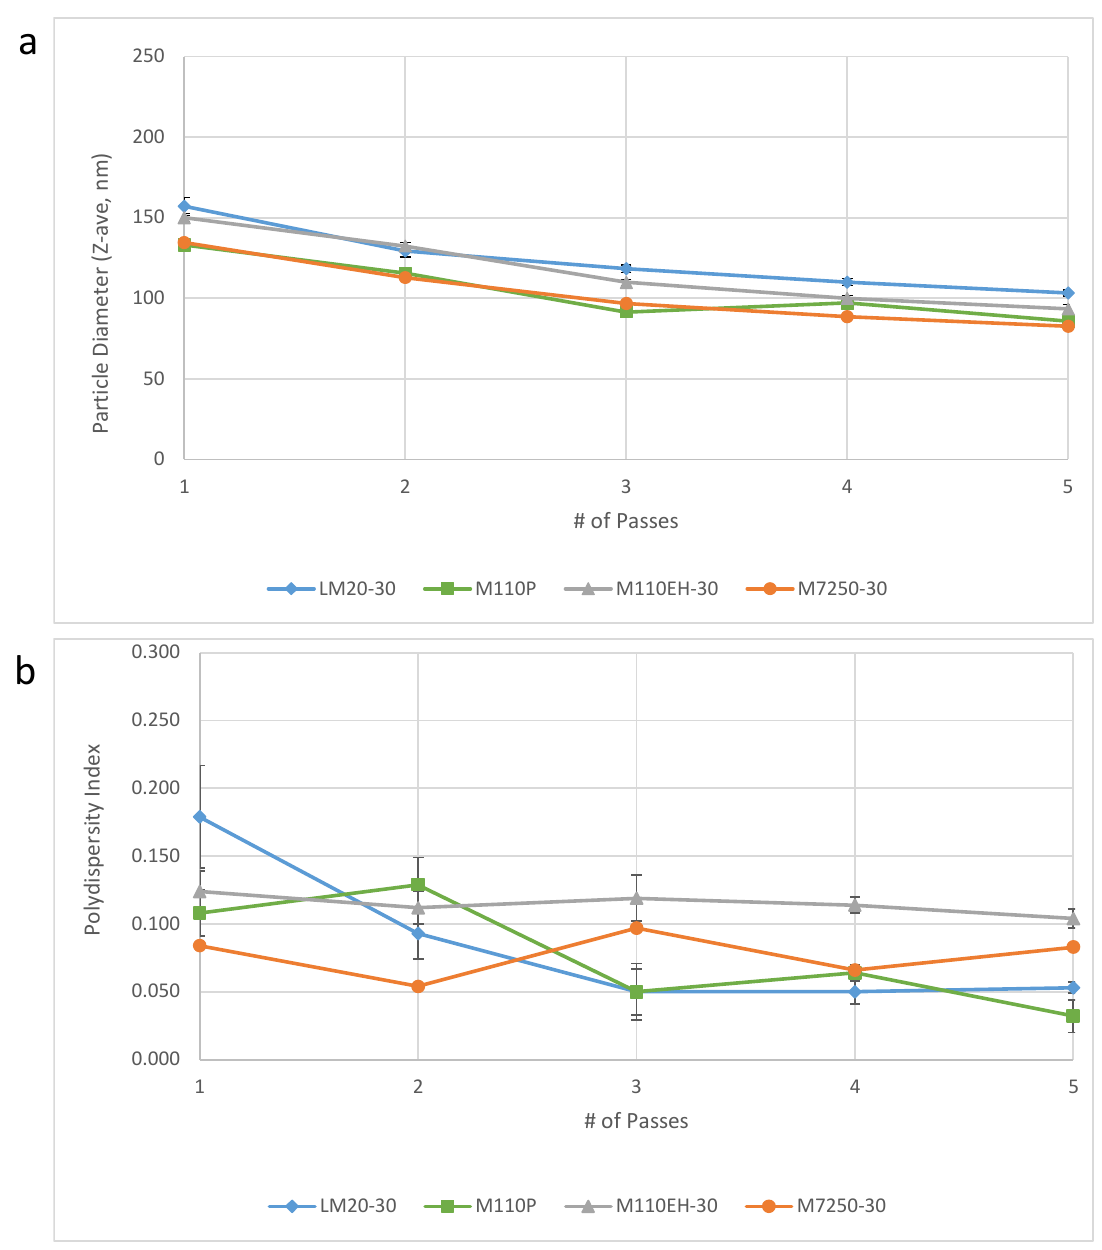
Figure 4. Droplet diameter ( a ) and polydispersity index ( b ) as a function of number of passes through the indicated Microfluidizer processor model. Error bars represent the standard deviation from three measurements from the same aliquot. The M-7250-30 data are taken from Figure 3. Batch size produced for each model was 10 L (M7250-30), 300 mL (M110-EH), 200 mL (M110P), and 100 mL (LM20). Typical representative flow rate for each Microfluidizer model when processing at 30,000 psi is 2.8 L / min (M7250-30), 400 mL / min (M110-EH), 110 mL / min (M110P), and 80 mL / min (LM20). Prior to Microfluidizer processing, high shear mixing conditions and equipment varied somewhat for the different batches although minimal impact is anticipated from these differences.